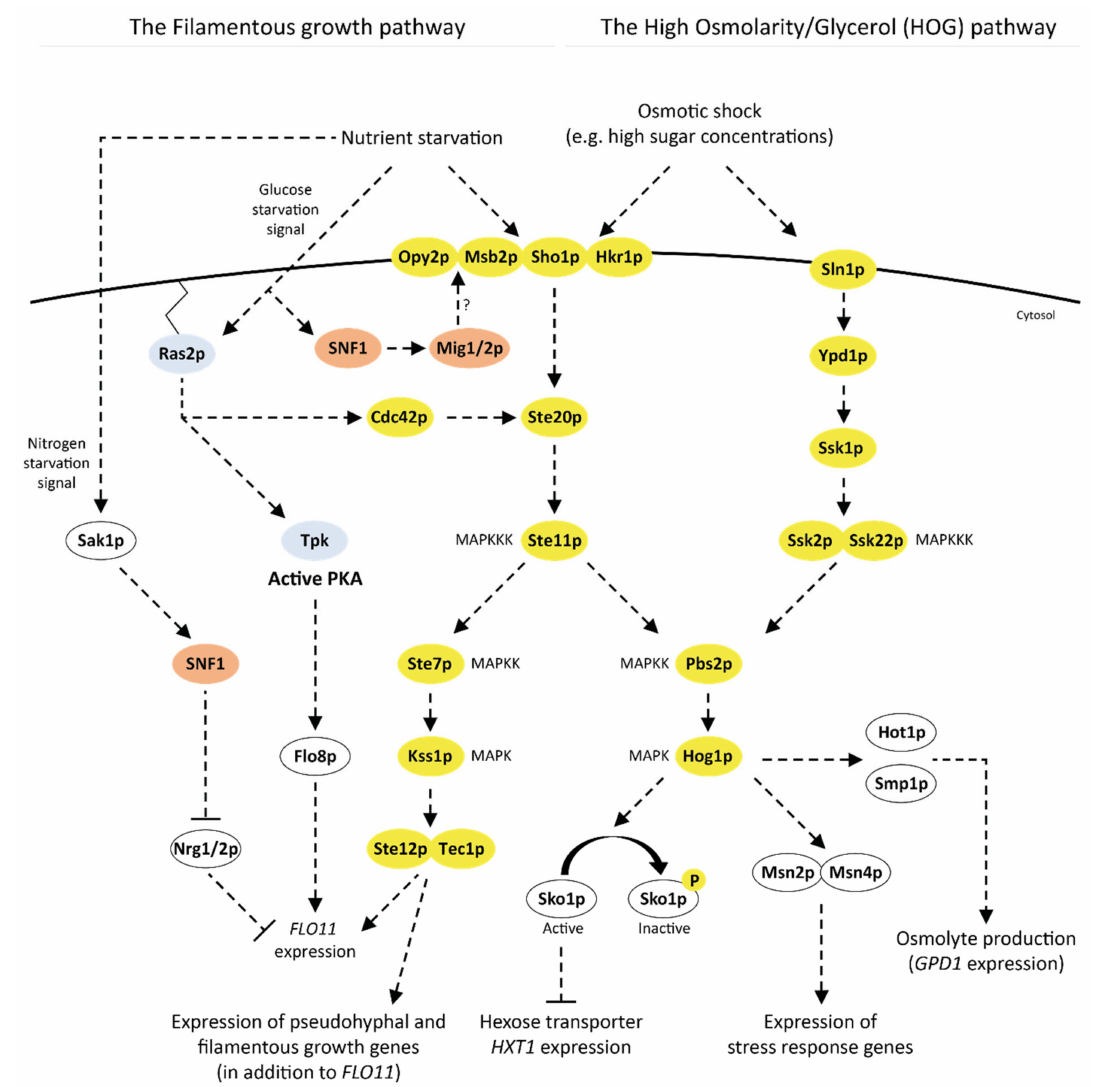
Figure 3. The High osmolarity/glycerol (HOG) pathway and the filamentous growth pathways respond to high D -glucose concentrations (high osmotic stress) and low D -glucose concentrations (nutrient starvation), respectively. The two pathways share many elements, due to Sho1p being involved in sensing both nutrient starvation and osmotic stress. Both pathways belong to the MAPK signaling pathways that transmit the regulatory signals through phosphorylation of target proteins. Note that all the MAPK pathway targets undergo activation and deactivation by phosphorylation, but that only Sko1p has been illustrated with these details in order to facilitate comparison with its activity in Figure 1. MAPK: mitogen activated protein kinase; MAPKK: mitogen activated protein kinase-kinase; MAPKKK: mitogen activated protein kinase-kinase-kinase. Arrows with arrowheads: induction; arrows with hammerheads: repression; dashed arrows: signaling. Yellow shapes: MAPK pathways (HOG1 and filamentous growth pathway); blue shapes: cAMP/PKA pathway elements; orange shapes: SNF1/Mig1p pathway elements; white shapes: proteins from other pathways. Adapted from [85,171,172]. During nutrient-limited conditions, yeast cells undergo a change in cell morphol- ogy to an elongated filamentous or pseudohyphal state that allows for improved nu- trient scavenging and invasive growth on semi-solid substrates [173]. The filamentous growth pathway senses nutrient starvation through a couple of differentiated signals, and to date, three different signal transduction chains have been identified in this pathway (Figure 3): (i) carbon and nitrogen starvation via Sho1p/Msb2p [174,175]; (ii) D -glucose starvation via Ras2p [164,176] and SNF1/Mig1p/2p [86]; and (iii) nitrogen starvation via Sak1p/SNF1 [177,178]. Sho1p has a regulatory role in both the HOG and the